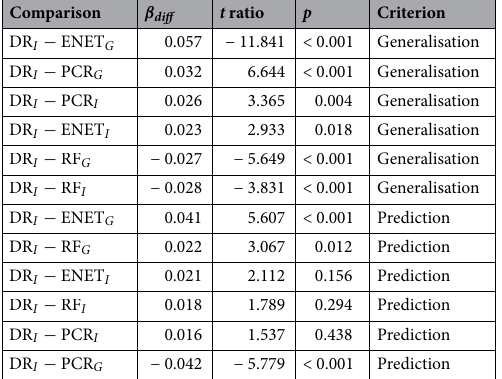
Table 2. Summary of models pairwise comparisons for generalisation and prediction abilities. β diff represents the marginal mean difference of the RMSE distribution between the DR model and its comparison.